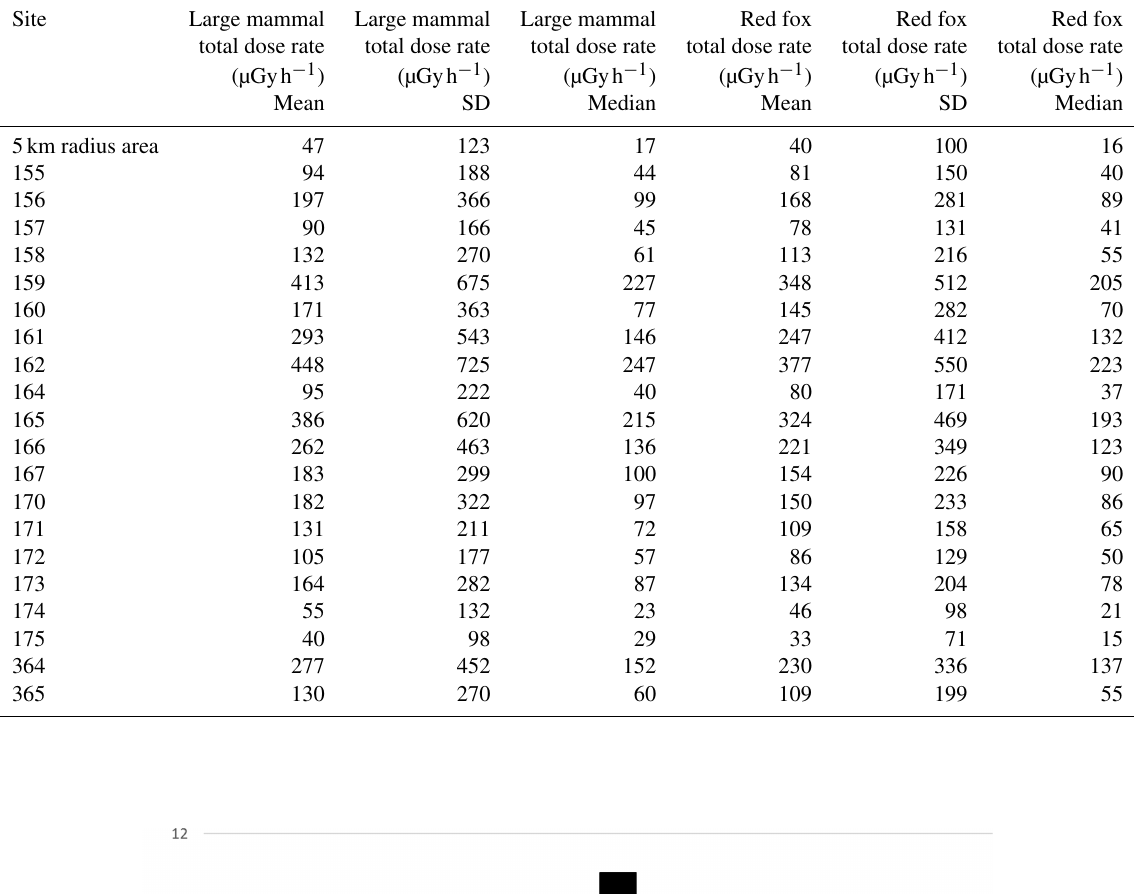
Table 3. Estimated weighted absorbed dose rates to mammals comparing those estimated for a large mammal (a deer) and a relatively small mammal spending some time underground (red fox). Estimates are presented for an area of 5km radius centred on the Red Forest and also for an area of 0.5km radius centred on each camera site.